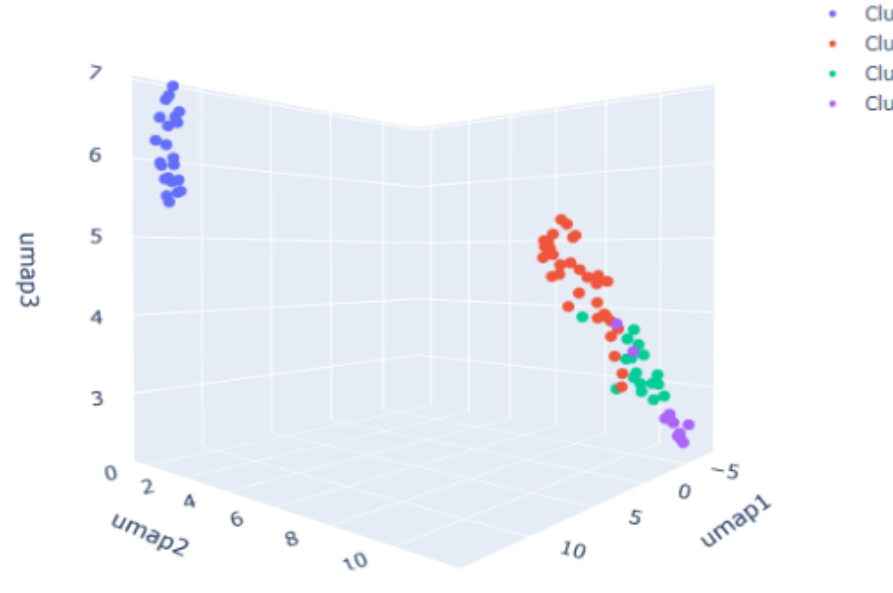
Figure 6. A scatter plot of UMAP representations with cluster labels.